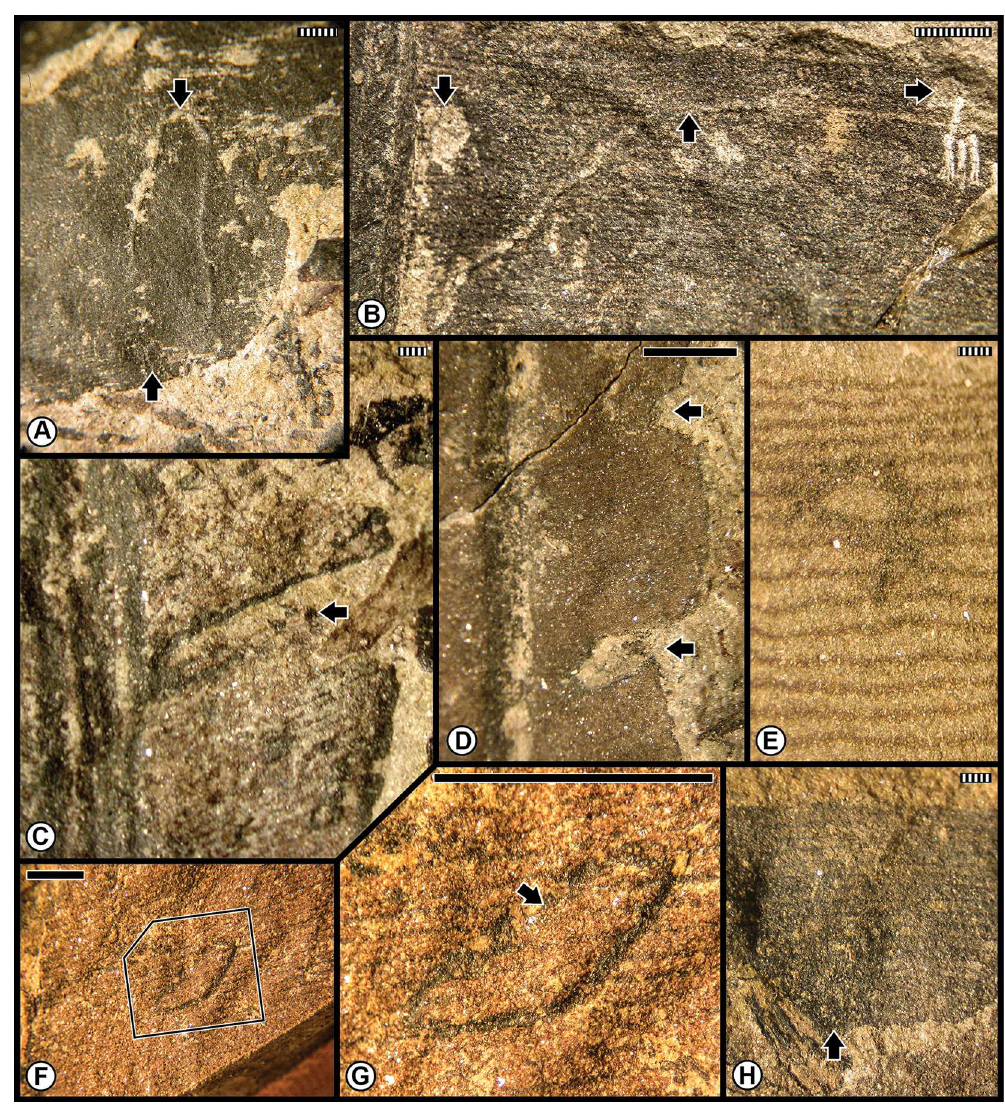
“ Pterophyllum ” sp., with a reaction rim indicated by a black arrow. SpecimenPAL-1685. B : Another specimen of “ Pterophyllum ” sp, but with a thread-like leaf mine (DT71) (central black arrow) originatingat upper right, with the probableoviposition mark (right black arrow), and terminating at upper left (left black arrow). The four vertical marks at upper-right are artifacts. Specimen PAL-1688. C : An example of trenched margin feeding (DT15) on Taeniopteris sp., with white arrow pointing to reaction-rimarea. Specimen PAL-1735. D : Cuspate margin feeding (DT12, upper arrow) and trenched margin feeding (DT15, bottom arrow) on Taeniopteris sp. Specimen PAL-2093. E : Interveinal surface feeding(DT11) on Taeniopteris sp. Specimen PAL-1853. F : A second example of surface feeding (DT30) on the cycadophyte Taeniopteris sp. Specimen PAL-1867. G : Enlargement of surface feeding indicatedby the template at (F), showinga reaction rim (black arrow). H : A gall on secondary veins (DT32) of a pinnuleof the cycadophyte Nilssonianeuberi . SpecimenPAL-590. All specimens are reposited in the Museum of Nature South Tyrol (MNS), in Bolzano, Italy. Scale bars: striped = 1 mm; solid = 10